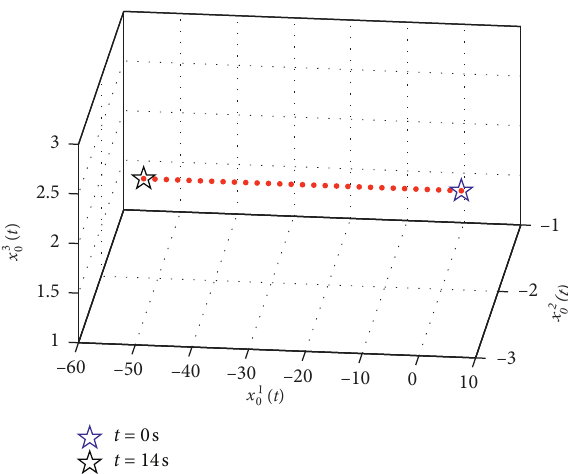
Figure 9: Movement track of the leader for time-invariant for- mation tracking case.